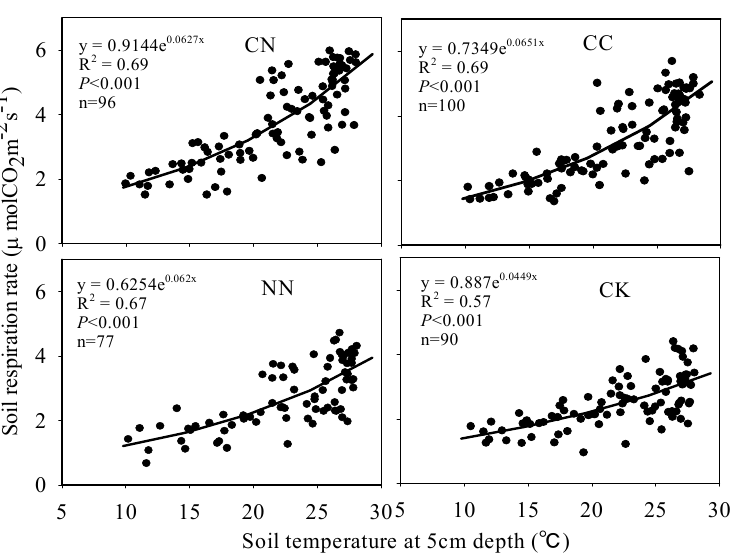
Fig. 2. Relationships between soil respiration rate and soil temperature at 5cm depth when soil moisture was larger than 15% under different CO 2 and N treatments. Each datum in panels CN and CC is the mean of three replications. Each datum in panels NN and CK is the mean of two replications. The treatments are: CK = control, NN = high N, CC = elevated CO 2 , CN = elevated CO 2 + high N.